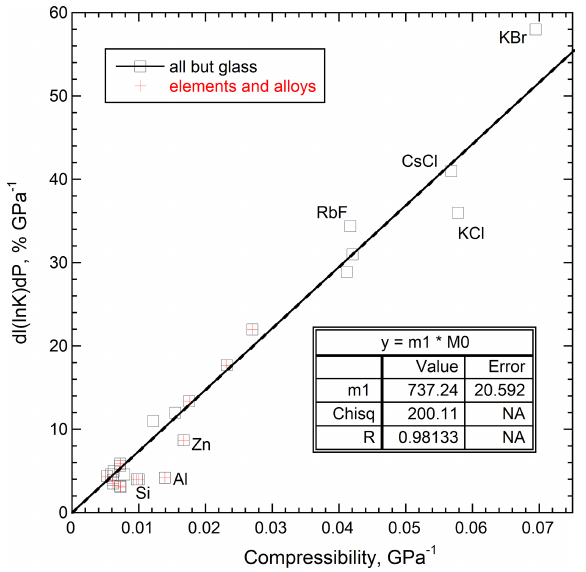
Figure 2. Measured pressure derivatives of thermal conductivity as a function of sample compressibility (the inverse of bulk modulus). All data were collected from millimeter-sized samples below 2GPa. The box lists parameters for a linear fit with no intercept. Metals and Si (red crosses) are included in the fit. KBr exemplifies hydro- scopic alkali halides which are soft (bulk moduli < 16GPa). Details on the 24 heat transport studies of this figure are given in Hofmeis- ter (2021), Table 3. Bulk modulus has been measured many times for the samples and is listed in the compilation of Bass (1995) and several